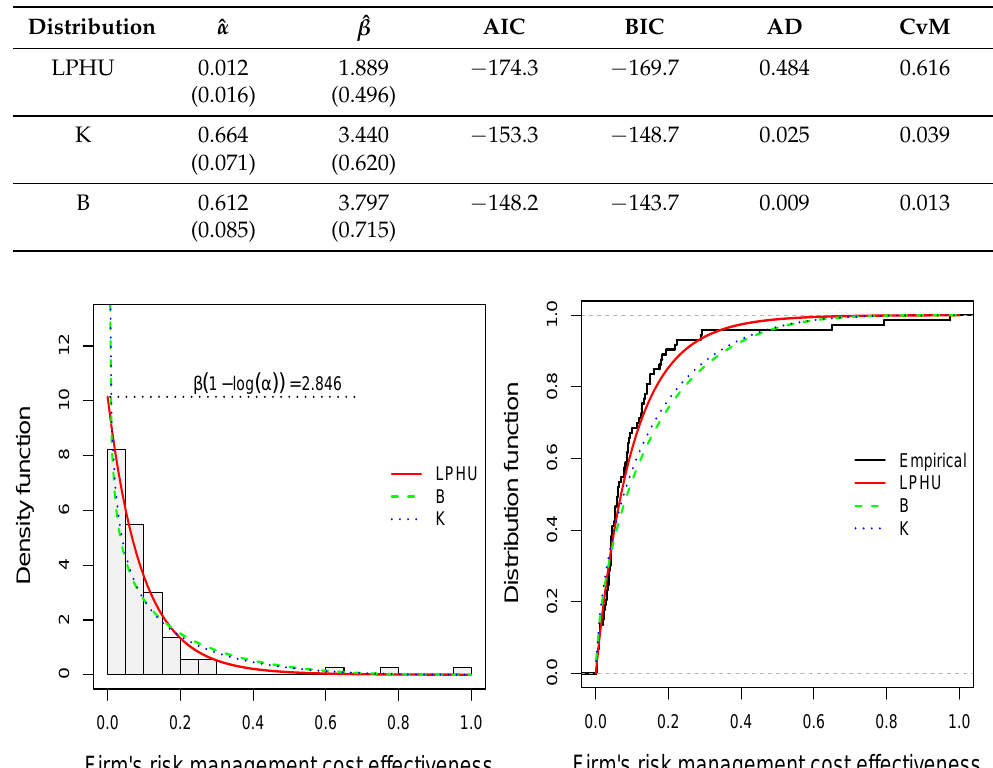
Figure 7. ( Left ): Histogram for the firm’s risk management cost effectiveness data and the fitted pdf curves via the ML method. ( Right ): Empirical cdf for the firm’s risk management cost effectiveness data and the fitted cdf